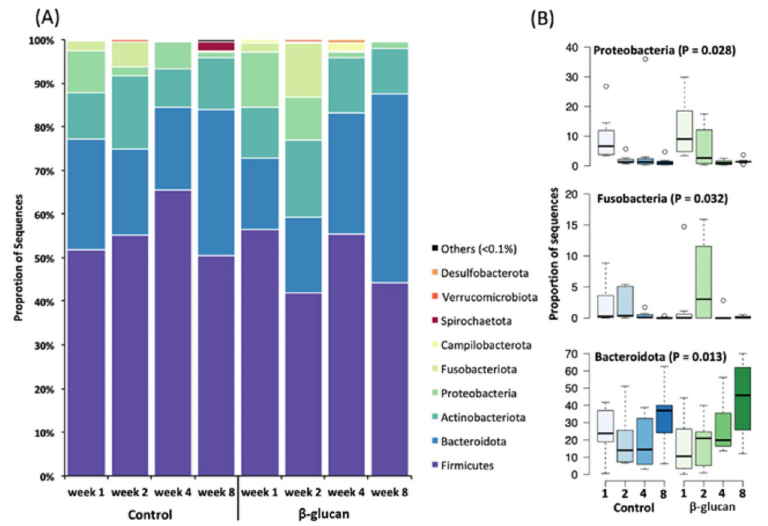
Fig 3. Bacterial composition in dairy calves’ feces fed milk replacer supplemented or not with β -glucans. (a) Phyla composition and (b) differential abundance over the weeks.